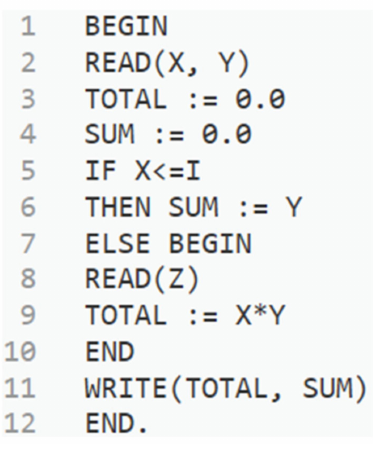
Figure 2. Static slicing sample